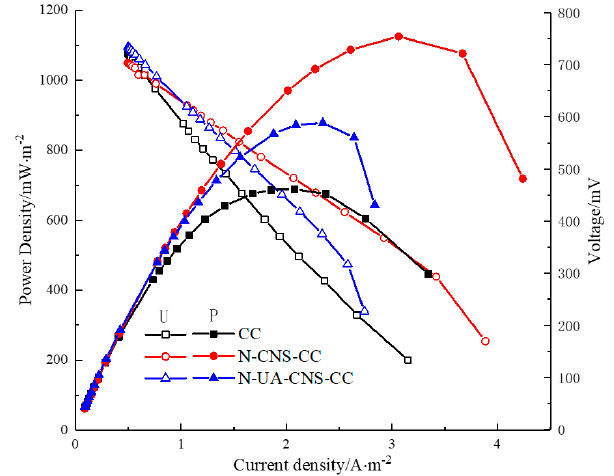
Figure 6. Polarization and power density of CC, the self-doped-nitrogen porous carbon nanosheets(N-CNS-CC) and the unactivated self-doped-nitrogen porous carbon (N-CNS-CC) and the unactivated self-doped-nitrogen porous carbon nanosheets(N-UA-CNS-CC) nanosheets(N-UA-CNS-CC) anode MFC. anode